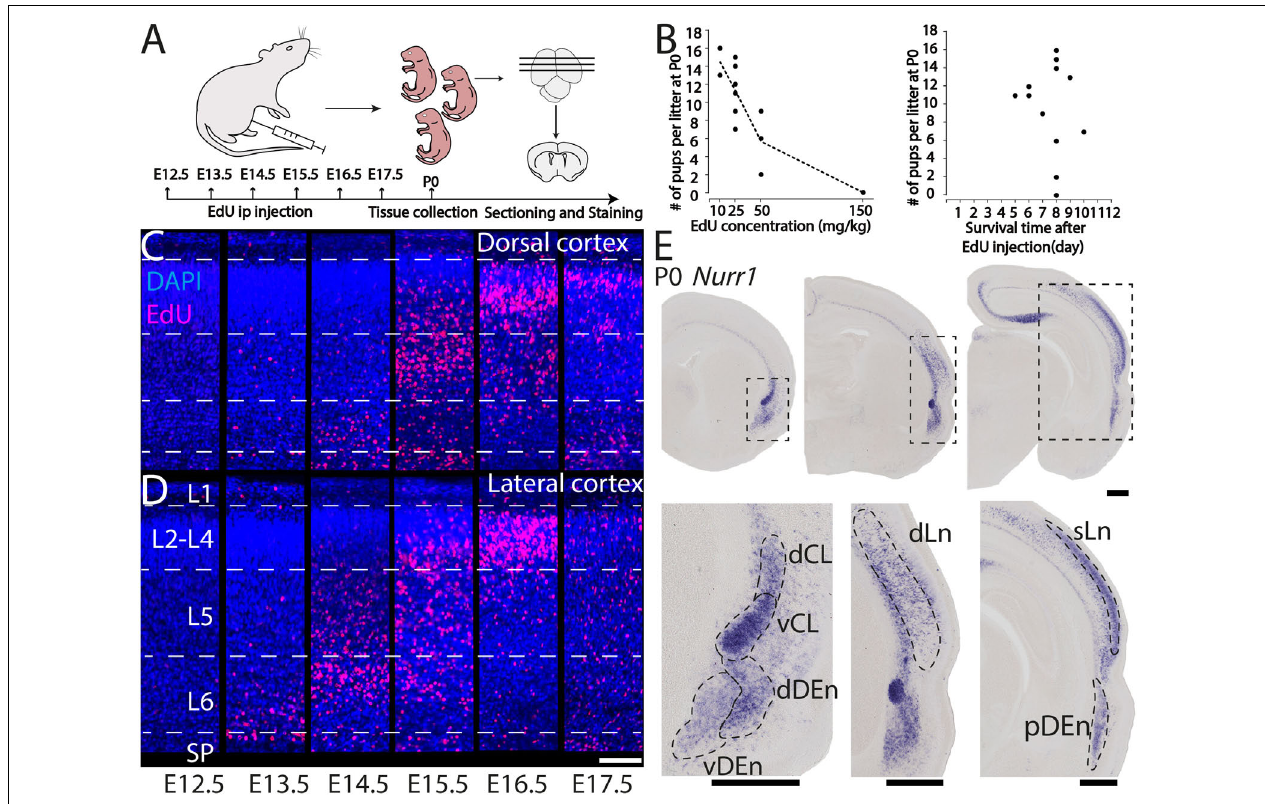
FIGURE 1 | Overview of technical approach. (A) Schematic diagram of EdU injections in pregnant rats from E12.5 to E17.5, followed at P0 by tissue collection, microtomy, and staining. (B) Relation of P0 rats survival rate with EdU concentrations and (left graph), and with survival time after EdU injection (right graph). EdU labeled P0 dorsal (C) and lateral (D) cortical sections from E12.5 to E17.5 injections. (E) Nurr1 expression in P0 sections from anterior to posterior, and magnified Nurr1 labeled regions including, dCL (dorsal claustrum), vCL (ventral claustrum), dDEn (dorsal DEn), vDEn (ventral DEn), dLn (deep layer neurons), sLn (superficial layer neurons), and pDEn (posterior DEn). Scale bar in panels (C,D) = 100 µ m. Scale bar in panel (E) = 0.5